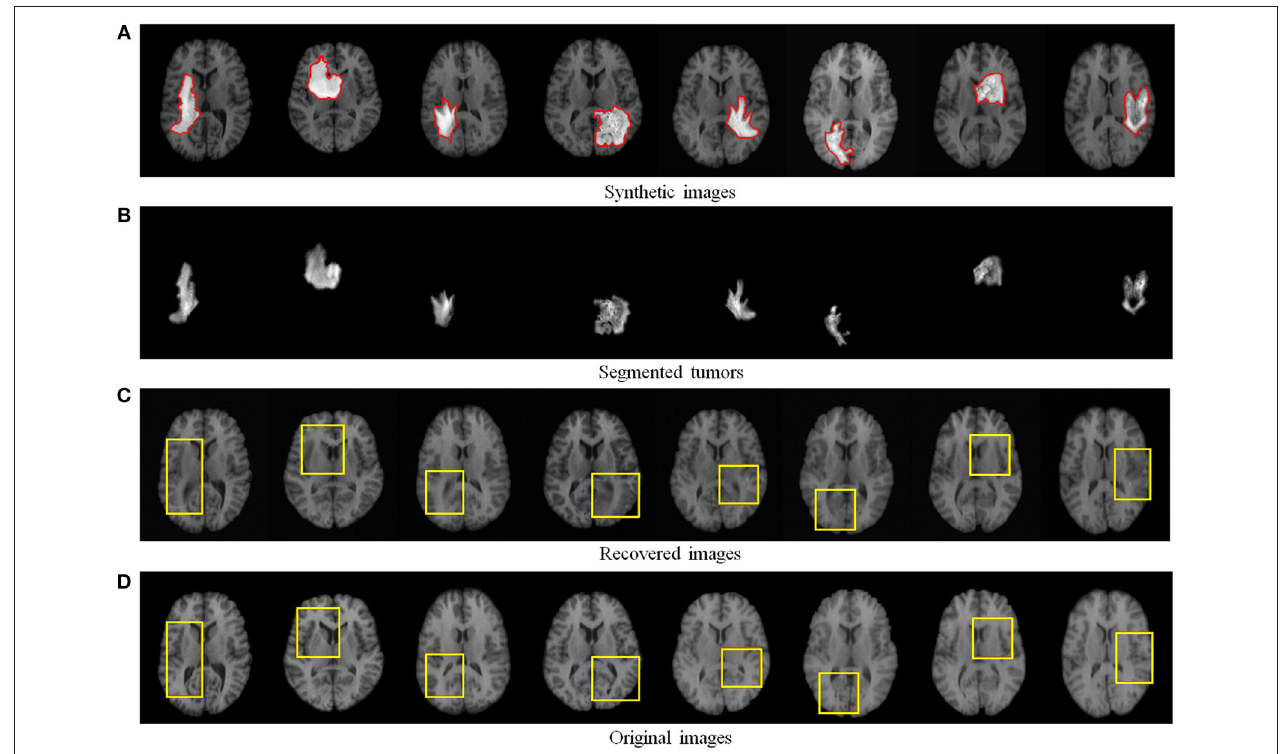
FIGURE 4 | Recovery and segmentation of (A) synthetic MR brain tumor images: (B) the segmented tumors, (C) the recovered images with normal brain appearances, (D) the corresponding original MR images from LPBA40 ( Shattuck et al., 2008). Yellow boxes illustrate the reliably recovered regions.